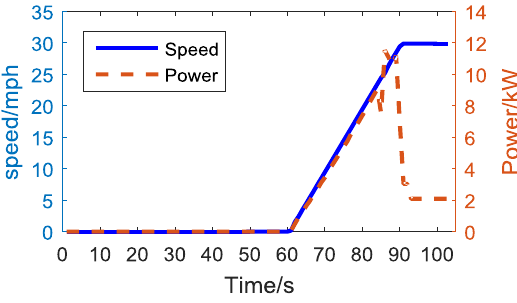
Figure 8. Speed and demanded power when starting up.